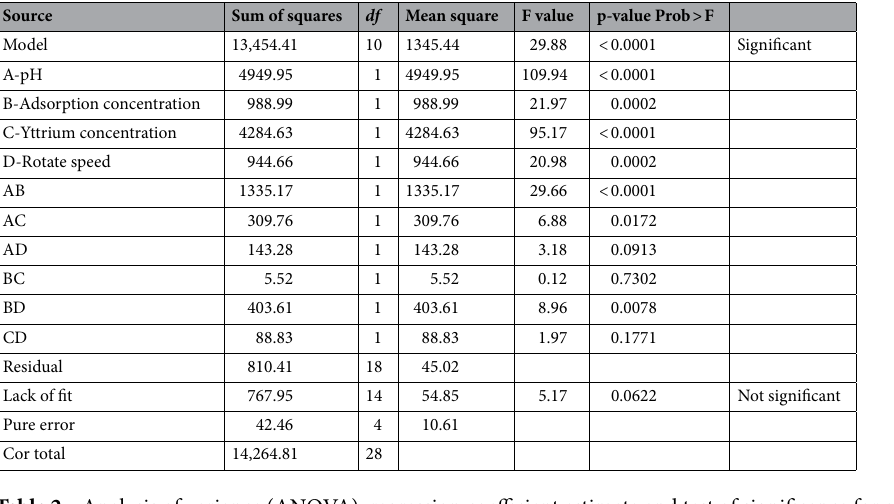
Table 2. Analysis of variance (ANOVA), regression coefficient estimate and test of significance for adsorption capacity of S. marcescens for Y (III) by design expert 8.0.6 R 2 :0.9432; Adjusted R 2 : 0.9116; Adequate precision: 19.477; Predicted R 2